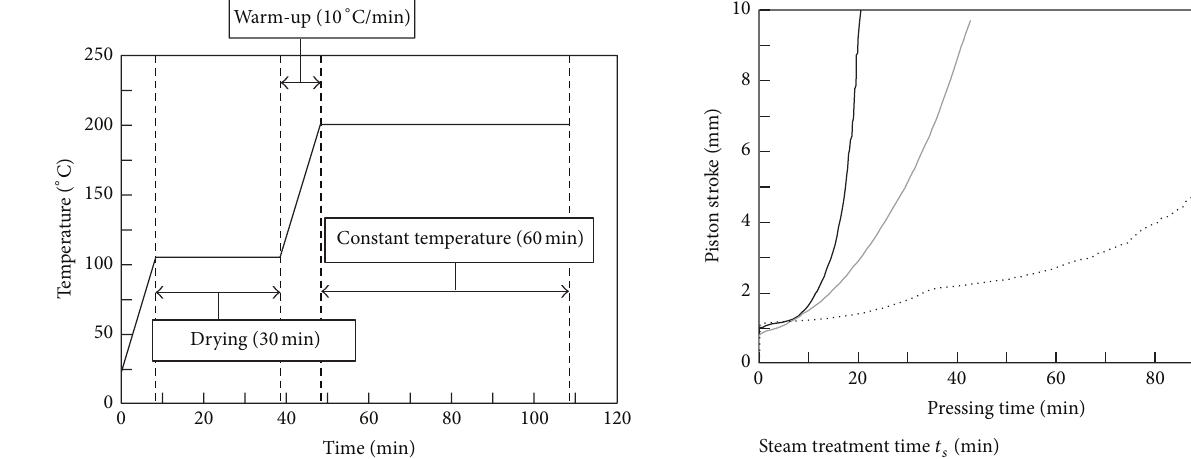
Figure 4: Thermogravimetry temperature schedule.